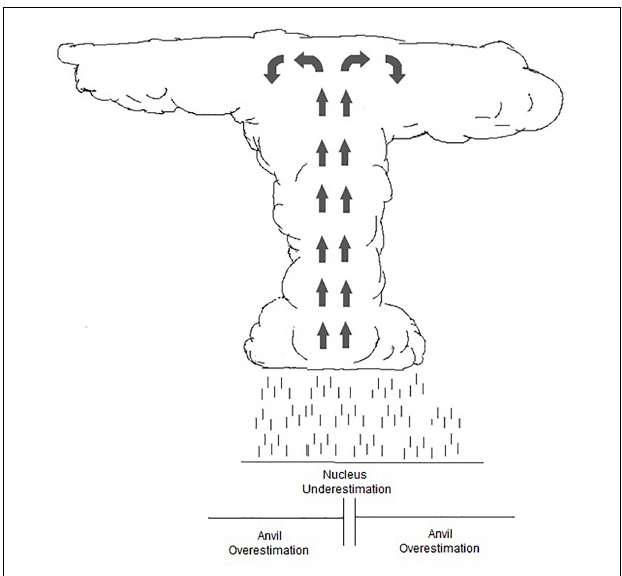
FIGURE 8 | Storm convective cloud diagram, identifying overestimated (nucleus) and underestimated (anvil) areas using the exponential model.